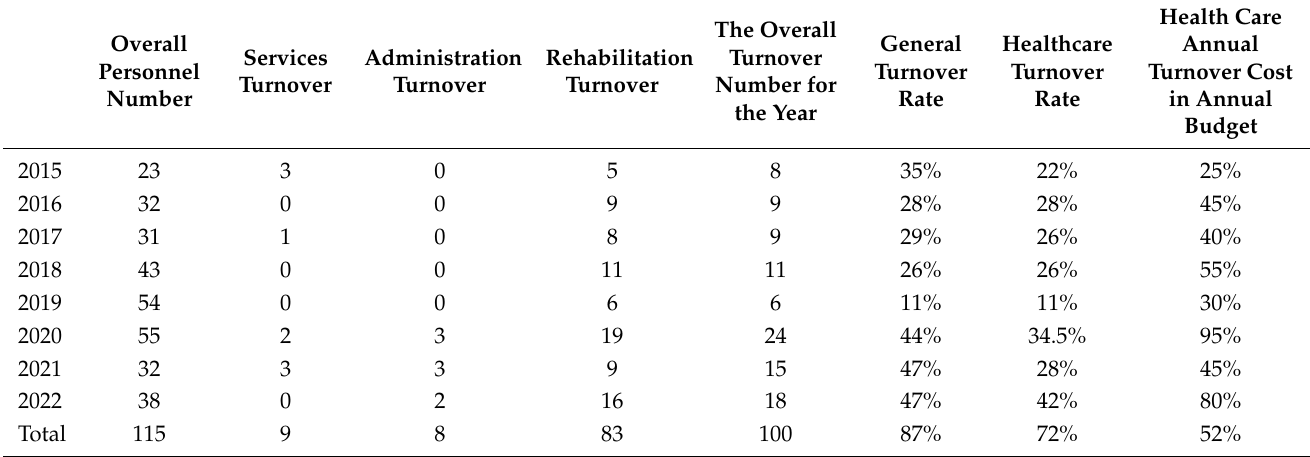
Table 2. The turnover rate in the center from 2015 to